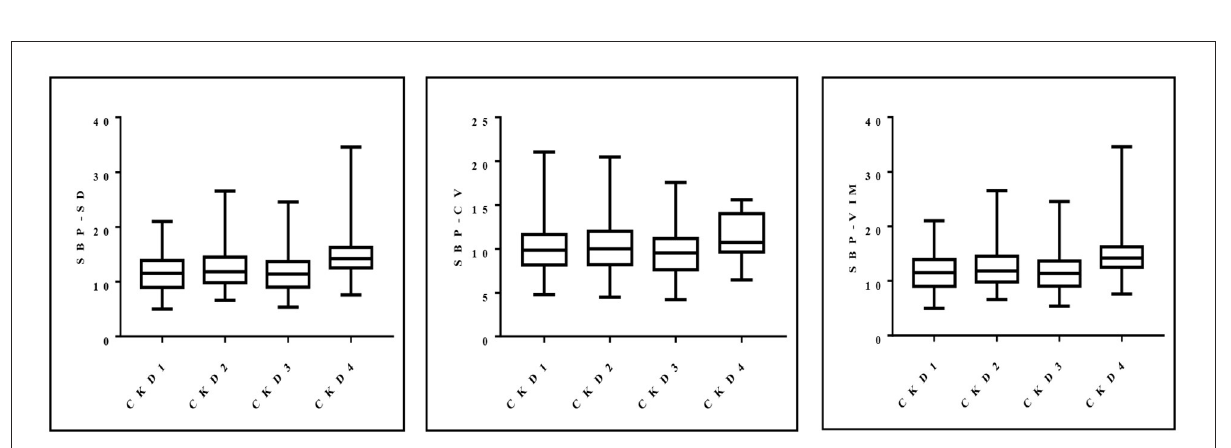
FIGURE1 Distribution of SD, CV and VIM of systolic blood pressure in patients with stages 1–4